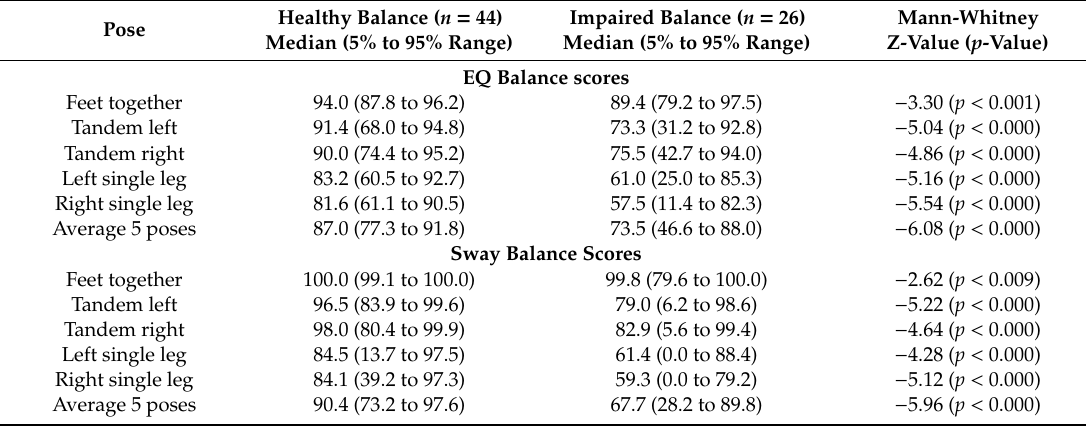
Table 3. Comparison of balance scores by group: healthy vs. impaired balance.